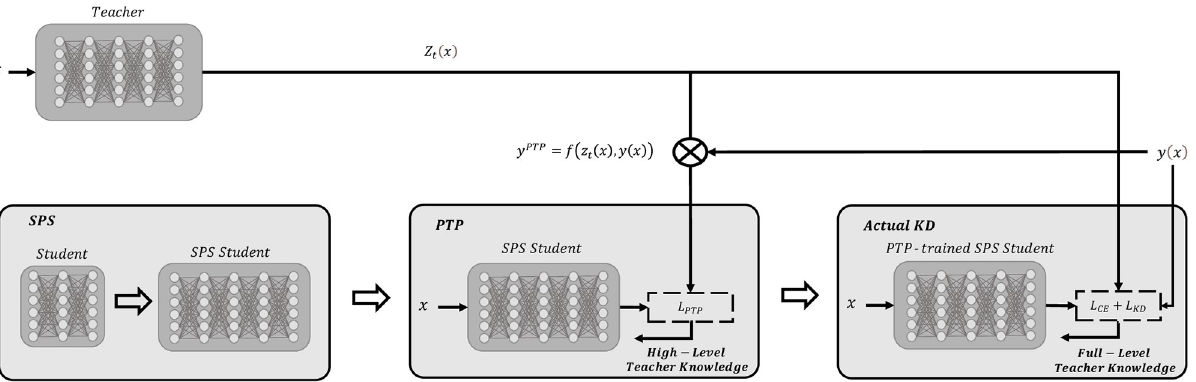
Fig 2. Overall framework of PeaBERT. The bottom left box represents applying SPS to the student model. The middle box illustrates applying PTP to the SPS-applied student model. The last box represents applying KD on the PTP-trained and SPS-applied student model. The final output is our PeaBERT